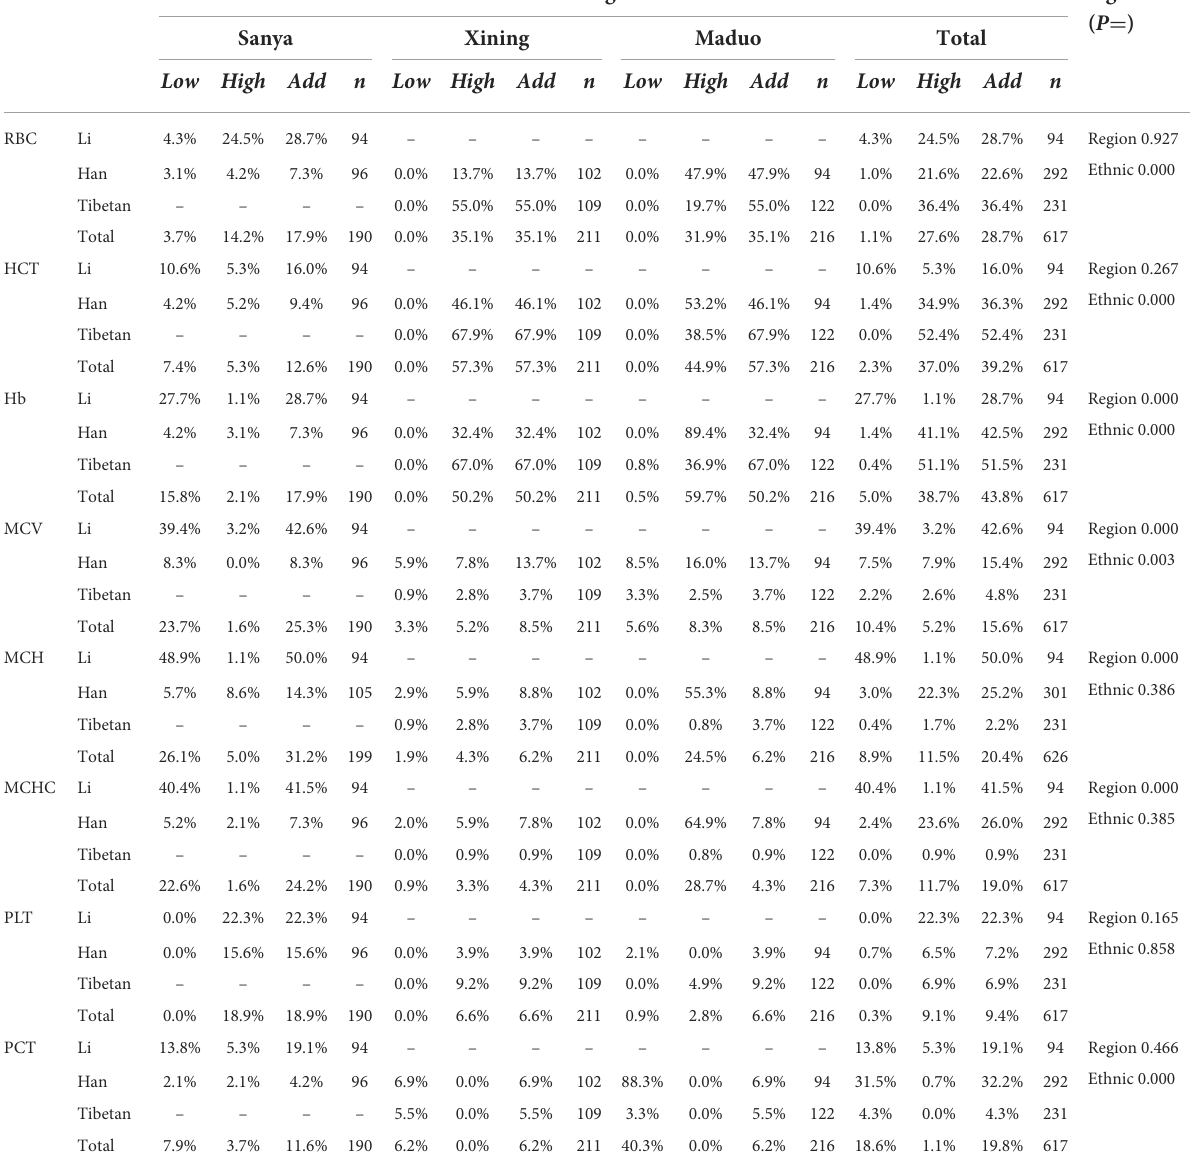
TABLE 5 RBT abnormal rate of the enrolled population